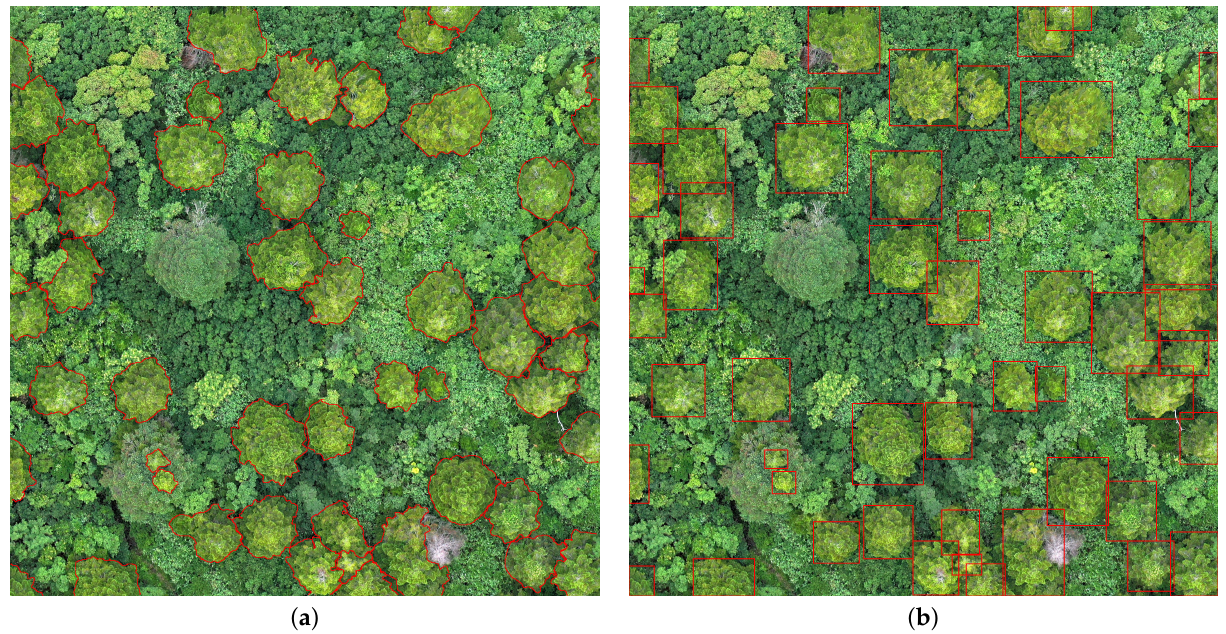
Figure 4. Examples of the tree detection problem. ( a ) Individual fir tree canopies are segmented manually. ( b ) bounding boxes are placed around each fir tree. The data depicted belongs to Zao mountain in Yamagata, Japan; see [63] for details on the